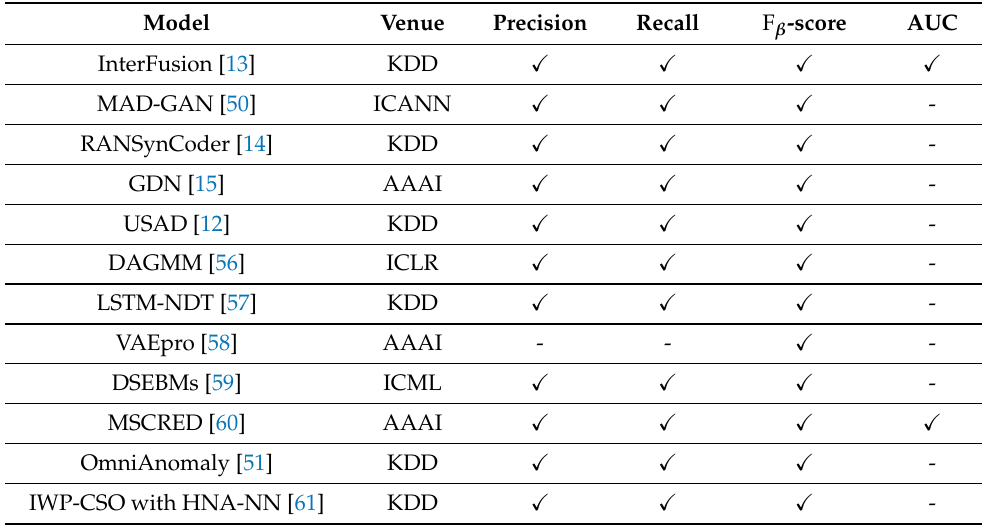
Table 2. Performance metrics of state-of-the-art in time series anomaly detection.